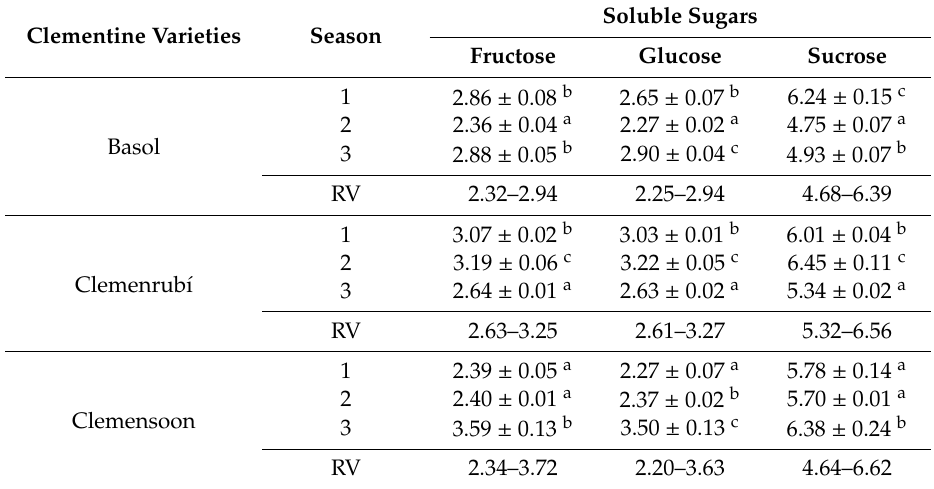
Table 3. Soluble sugars (mg / 100 g fw of fruit edible portion) in extra early clementine